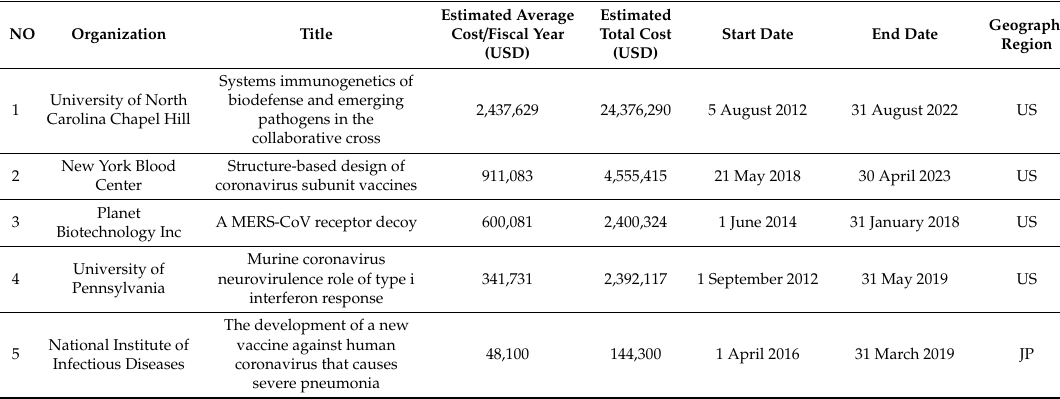
Table 3. Research related to the platform for an immunological response to viral infection and vaccine development (Sub-Cluster